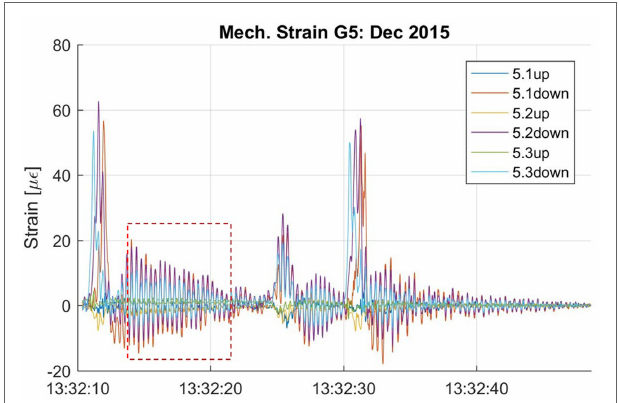
FIGURE 13 | Typical strain response of monitored highway overpass.